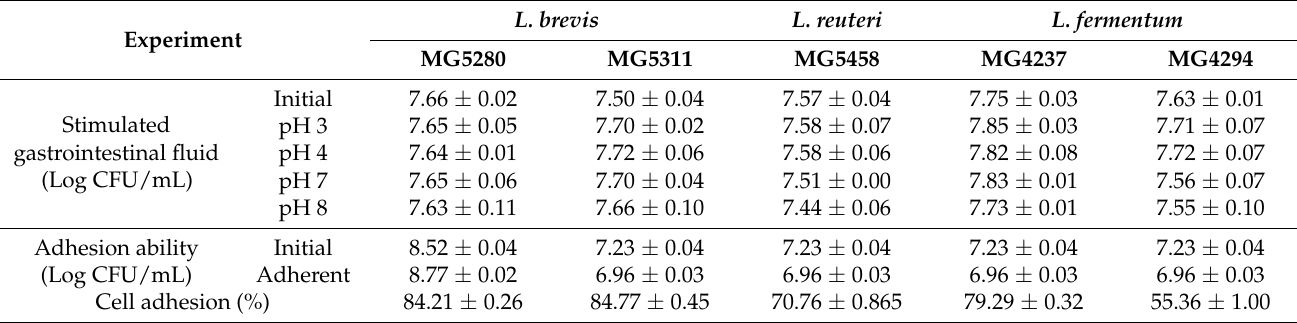
The properties of L. brevis MG5280 and MG5311, L. reuteri MG5458, and L. fermentum MG4237 and MG4294 as probiotics were assessed in artificial GIT, including their adhesion ability to HT-29 colorectal cells (Table 3). In stimulated GIT, all strains had a survival rate of >98%. The cell number in the stimulated GIT ranged from 7.44 to 7.85 Log CFU/mL; the initial cell number ranged from 7.50 to 7.75 Log CFU/mL. Additionally, all strains could adhere to HT-29 colorectal cells, with an adhesion rate ranging from 55.36 to 84.77%. Among them, L. brevis MG5280 (84.21 ± 0.26%) and MG5311 (84.77 ± 0.45%) showed high adhesion rates. Table 3. Tolerance to artificial GI tract and adhesion of L. brevis MG5311 and L. fermentum MG4237 to HT-29 cells.